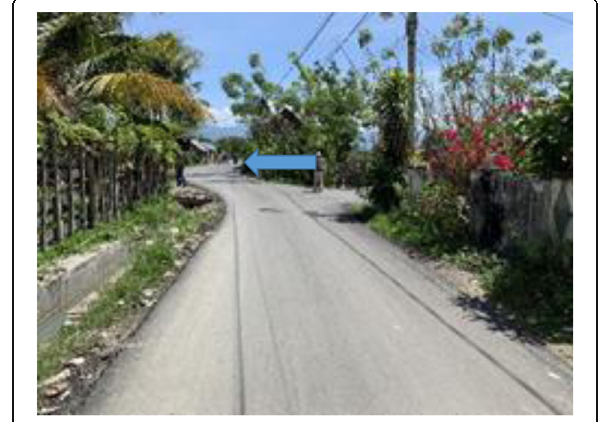
Fig. 5 Large ground displacement of 3.8m at Cemara street in Palu city